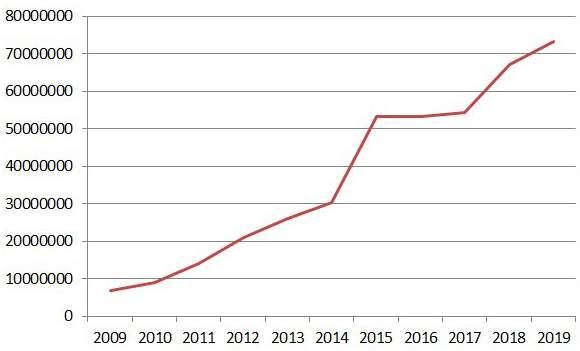
Fig. 1 Number of tourists in Lanzhou City during